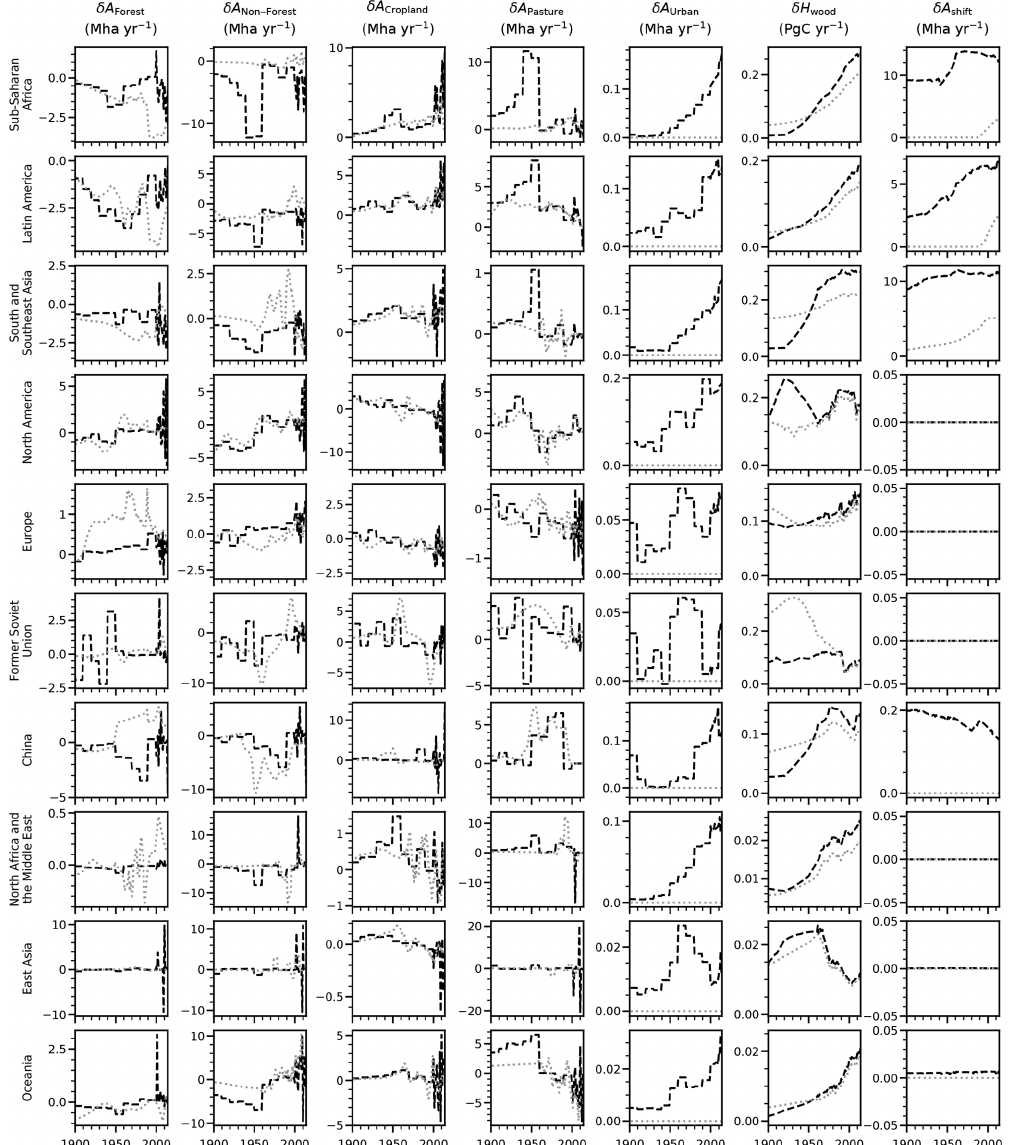
Figure A2. Summary of LULCC drivers in LUH2-GCB2019 (dashed black lines) and FRA2015 (dotted gray lines). For each region (rows), the first five columns show net changes in our five biomes (in order: forest, non-forest, cropland, pasture, and urban), the second-to-last column shows wood harvest, and the final column shows total area under shifting